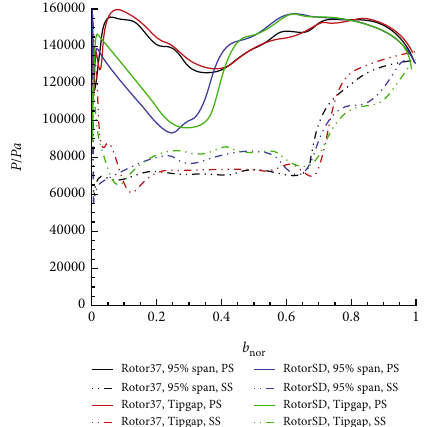
Figure 21: Distributions of the static pressures on the pressure and suction surfaces at the 95% span and along the chord.